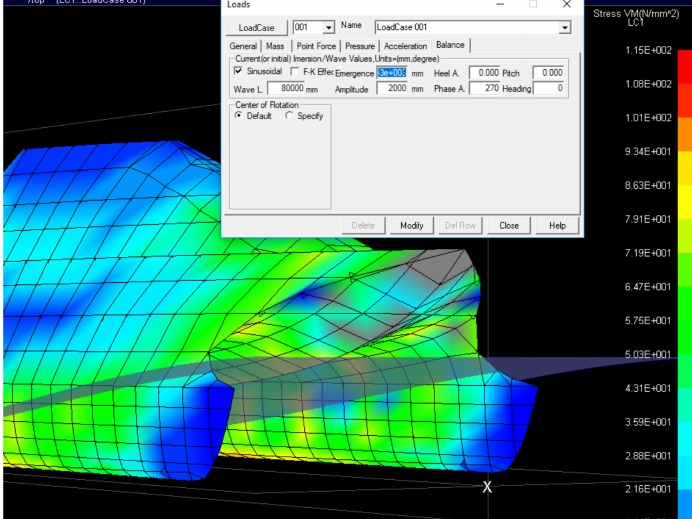
Figure 9. Applied wave specifications for the FEA